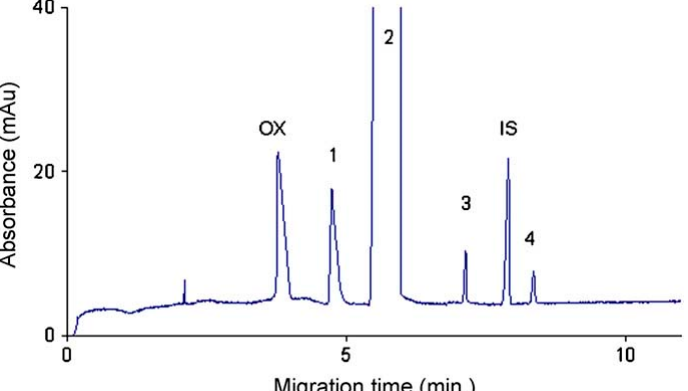
Figure 1. Electropherogram of 5 mg/mL S-CIT oxalate containing approximately 2.4% R-CIT and 0.1% of citadiol enantiomers (1- R -CIT, 2- S -CIT, 3- S -citadiol, 4- R -citadiol, OX-acid oxalic, IS- internal standard (salicylic acid); experimental conditions: 20 mM phosphate BGE, pH 2.5, CS 22 mg/mL S- β -CD + 0.5 mg/mL β -CD, − 20 kV voltage; 28 °C temperature; 50 mbar/5 s injection, detection at 205 nm) Reprinted from Sungthong et al. [41] with permission from Elsevier